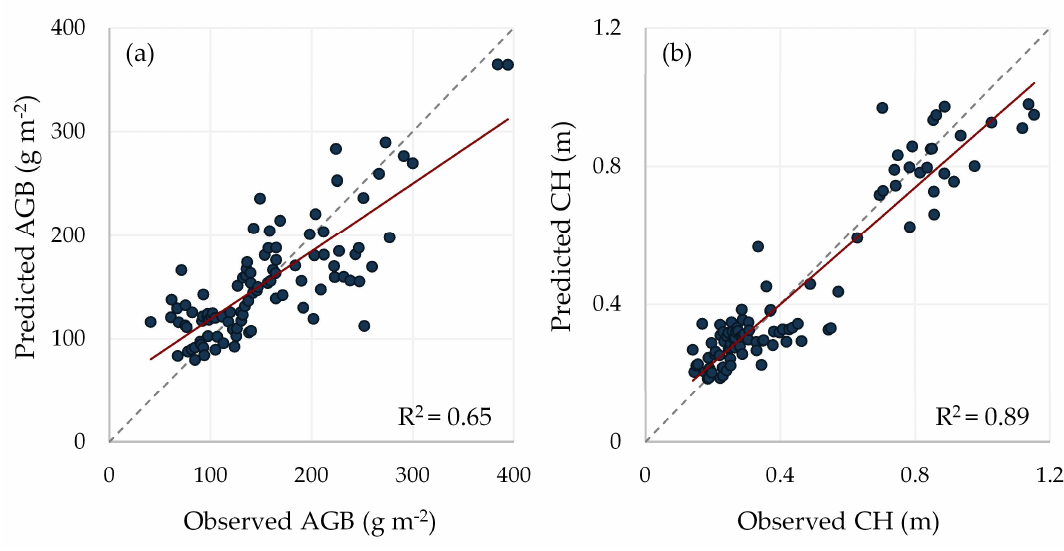
Figure 5. Scatterplots of the predicted versus measured values of pasture aboveground biomass (AGB, g m − 2 ) ( a ) and canopy height (CH, m) ( b ) obtained using the best extreme gradient boosting (XGBoost) model based on the testing dataset. A 1:1 line (grey, dashed) is provided for reference.